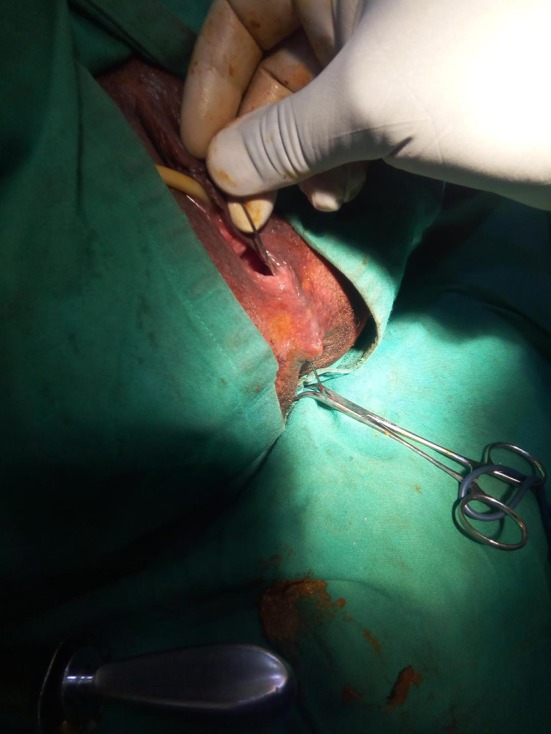
Low rectovaginal fistula delineated with probe.